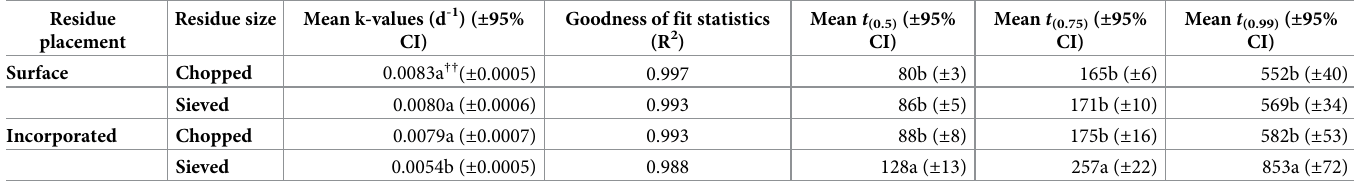
Table 4. First-order decay model parameters for sequential barley residue decomposition under residue placement and residue size treatment combinations aver- aged across soil types in 50-days’ laboratory incubation study at 25˚C. Residue